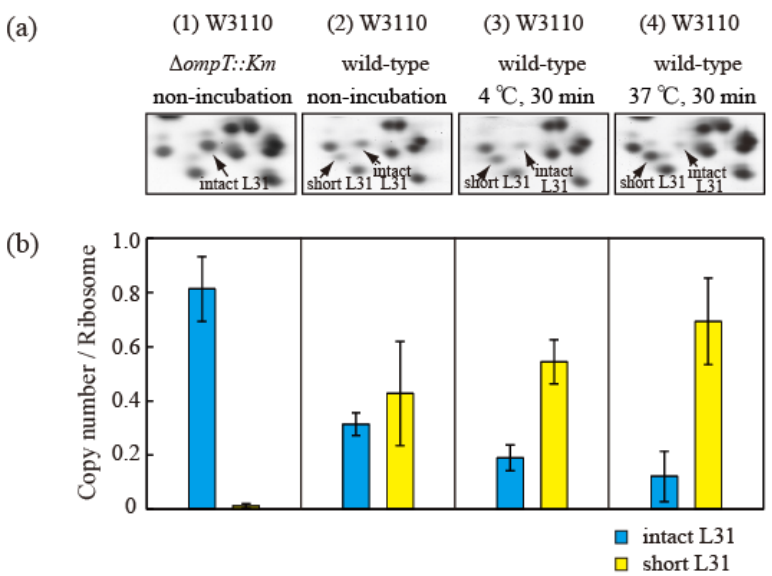
Figure 5. Intact bL31 is cleaved by protease 7 to generate short bL31 during the incubation of disrupted cells. W3110 Δ ompT::Km and wild-type cells were grown at 37 °C in EP medium and collected in the exponential growth phase (Klett units: 50), and high-salt-washed ribosomes (HSRs) were prepared. These samples were designated (1) and (2) “non-incubation”. To stimulate cleavage of the C-terminal residues of intact bL31, disrupted W3110 cells were incubated at (3) 4 °C or (4) 37 °C for 30 min. ( a ) r-proteins of the four samples of HSRs were analyzed by means of RFHR 2D PAGE. Relevant gel areas are shown. Arrows indicate spots corresponding to intact and short bL31s. ( b ) The protein copy number per ribosome was determined. Copy numbers of intact and short bL31s are shown as cyan and yellow bars, respectively. The experiment was repeated at least three times. The bars and error bars show the mean copy numbers of bL31 and standard deviations, respectively. In Figure 5, the “b” of r-proteins has been omitted.